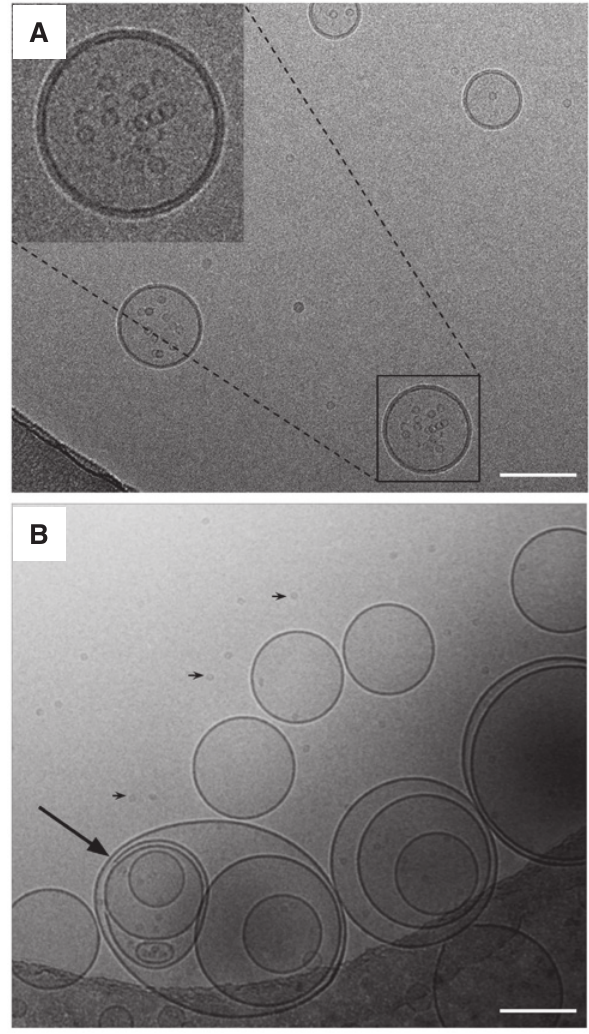
Figure 5: Encapsulation of apoferritin and urease investigated by cryo-EM. E. coli polar lipid extract liposomes were formed in 20 mm Tris-HCL pH 7.6, 1 mm EDTA buffer containing the indicated additional component and dispersed in the same buffer without it. (A) Apoferritin, 2 mg/ml. Some liposomes contained apoferritin and retained it when the buffer was exchanged by size exclu- sion chromatography. In some cases, the amount was more than expected from the distribution of apoferritin at the same concen- tration in the same buffer without lipids. This might be caused by spontaneous encapsulation as reported for ferritin [9]. The few apoferritin complexes in the background of the image are prob- ably from liposomes that opened during the size chromatography or vitrification steps. (B) Urease, 3.5 mg/ml. Encapsulation was probably not successful. After size exclusion chromatography,